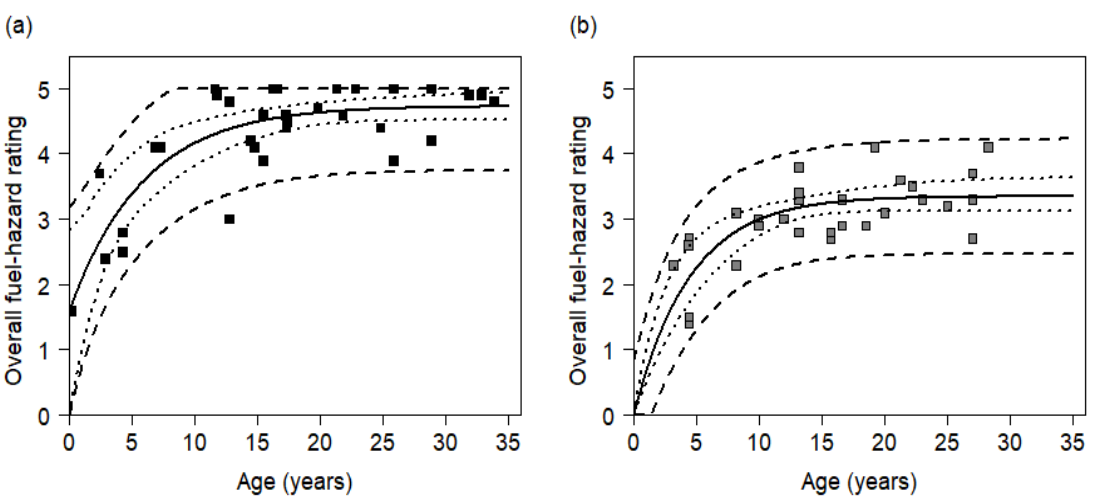
Figure 8. Modelled overall fuel hazard accumulation curves (solid lines) with confidence bands (dotted lines) and prediction bands for new sites (dashed lines). ( a ) NE sites—black squares; ( b ) SE sites—grey squares.